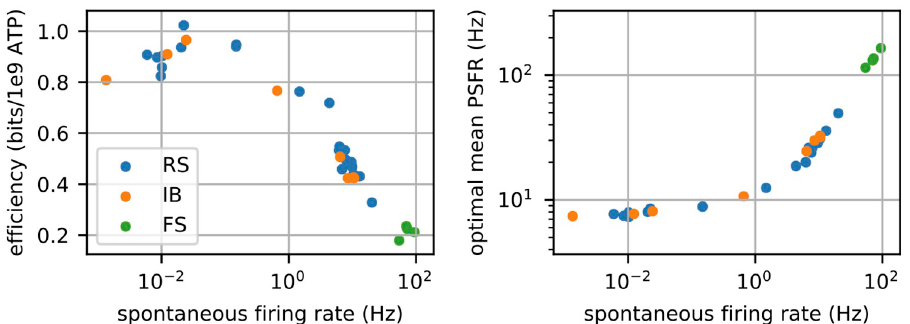
Fig 9. Cortical neurons. The x -axis in both graphs is the spontaneous firing rate of the 34 neuronal models corresponding to the cortical neurons, i.e., their response to the simulated background noise. The information- metabolic efficiency (Eq (18)) and optimal mean PSFR (Eq (22)) was calculated for the case of constant inhibition ( B = 0, Δ = 100 ms).